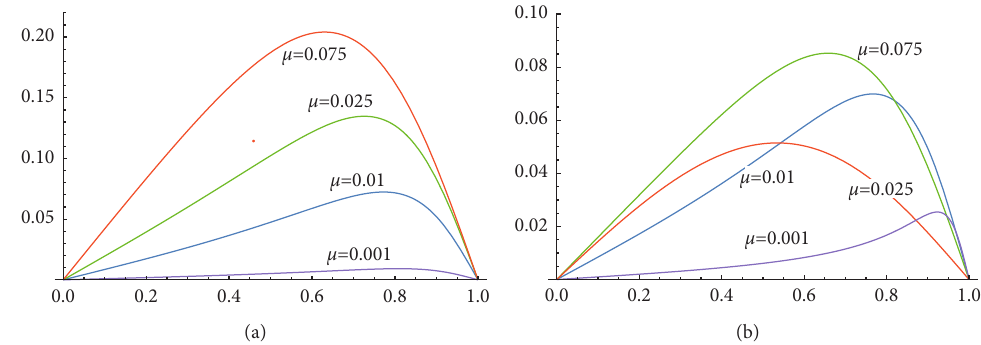
Figure 5: The approximate solution for different values of μ and 0 ≤ x ≤ 1 , a � 1, and T